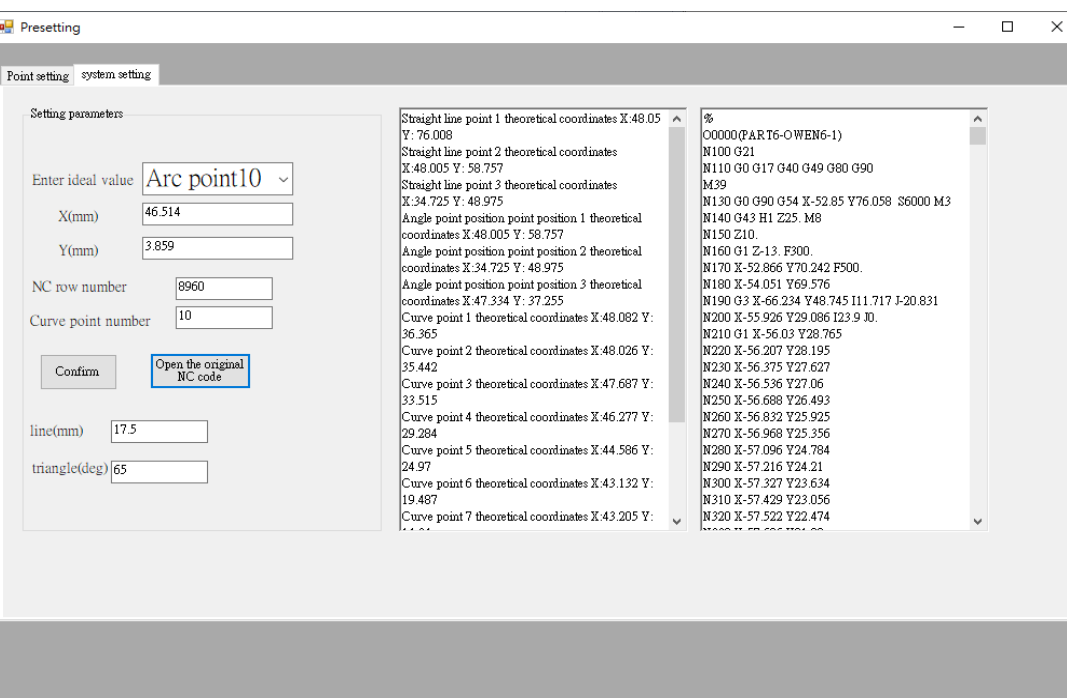
Figure 7. HMI—Point setup interface.